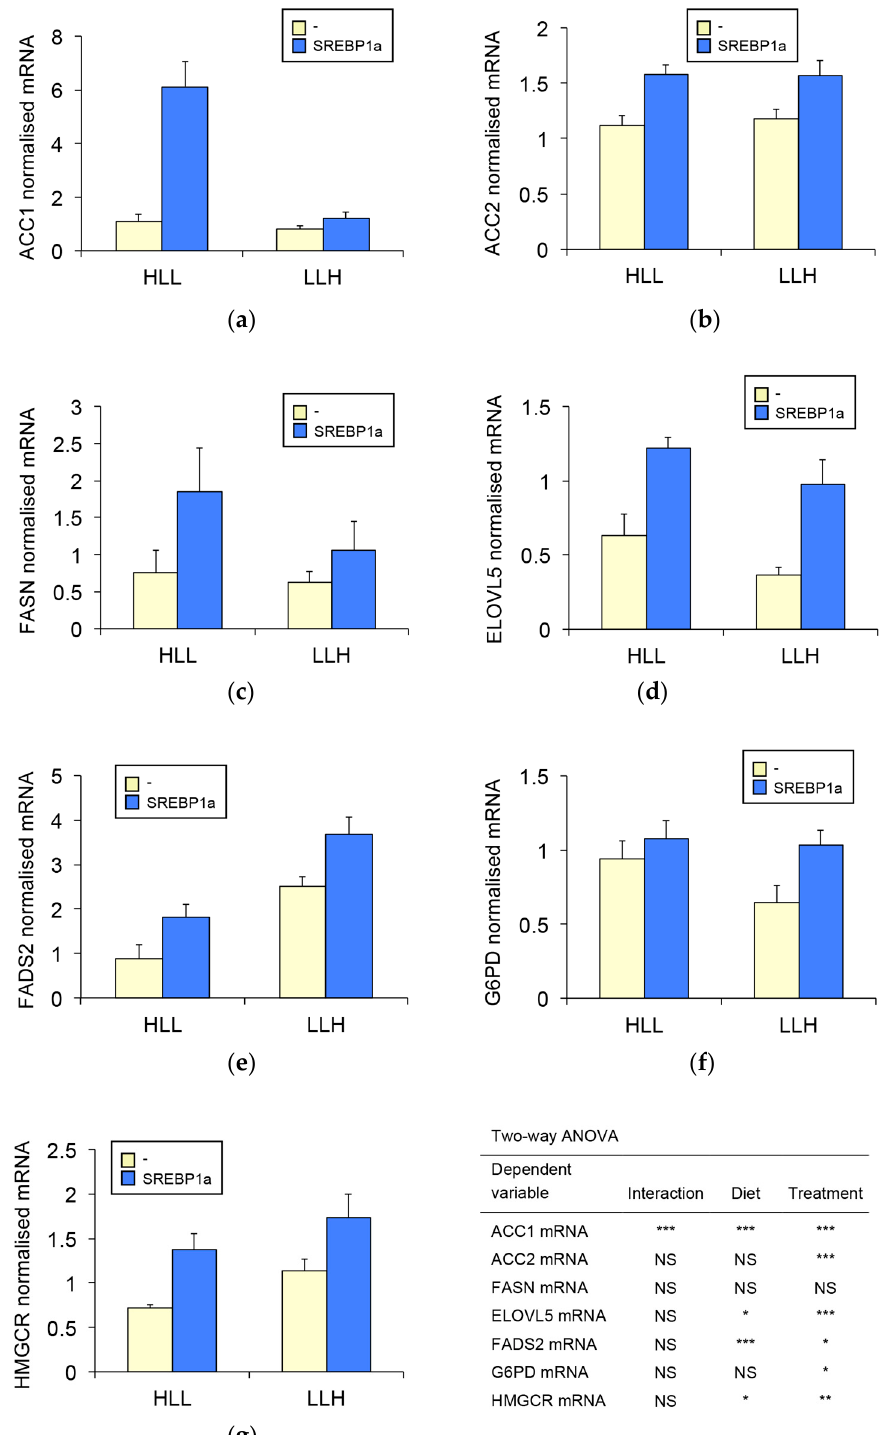
Figure 4. Effect of chitosan-TPP-pSG5-SREBP1a administration on the expression of key enzymes in the synthesis of fatty acid and cholesterol in the liver of S. aurata . Twenty-four hours after the last meal, fish fed diet HLL or LLH were intraperitoneally administered with chitosan-TPP nanoparticles complexed with 10 μ g/g BW of pSG5 (-) or pSG5-SREBP1a (SREBP1a). Seventy-two hours following the treatment, the liver was collected and RNA isolated. Hepatic mRNA levels of ACC1 ( a ), ACC2 ( b ), FASN ( c ), ELOVL5 ( d ), FADS2 ( e ), G6PD ( f ) and HMGCR ( g ) are presented as mean ± SEM ( n = 6). Expression levels for each gene were assayed by RT-qPCR and normalised with the geometric mean of ribosomal subunit 18s, β -actin and EF1 α . Statistical significance for independent variables (diet and treatment) are indicated as follows: * p < 0.05; **p < 0.01; ***p < 0.001; NS not significant.